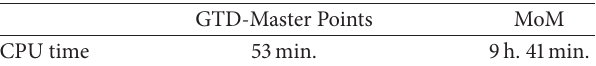
Table 2: Comparison of the CPU time need for the analysis when GTD-Master Points and MoM techniques are